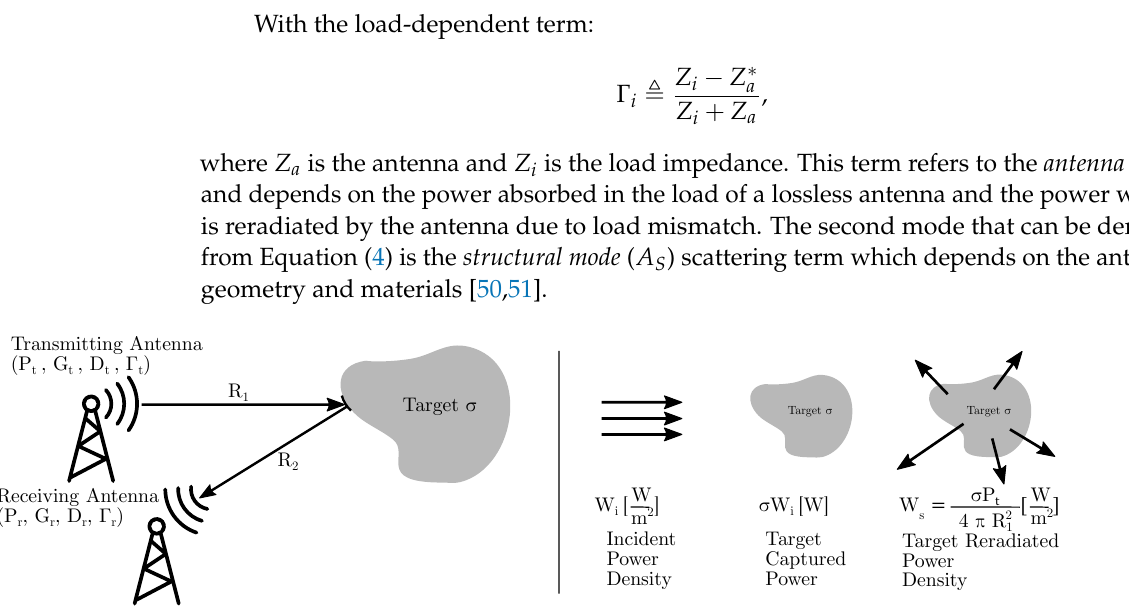
Figure 5. Simplified visualization of the radar cross-section